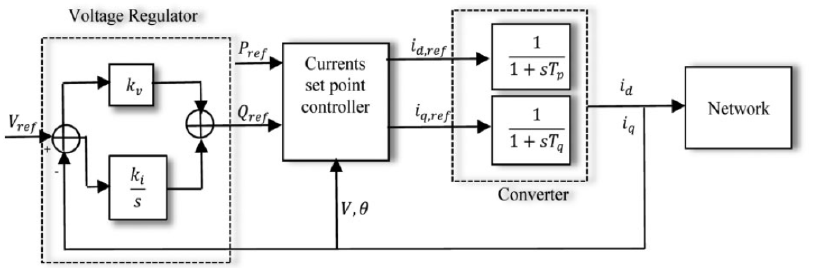
Figure 4. Dynamic SPVGP model with inverter.